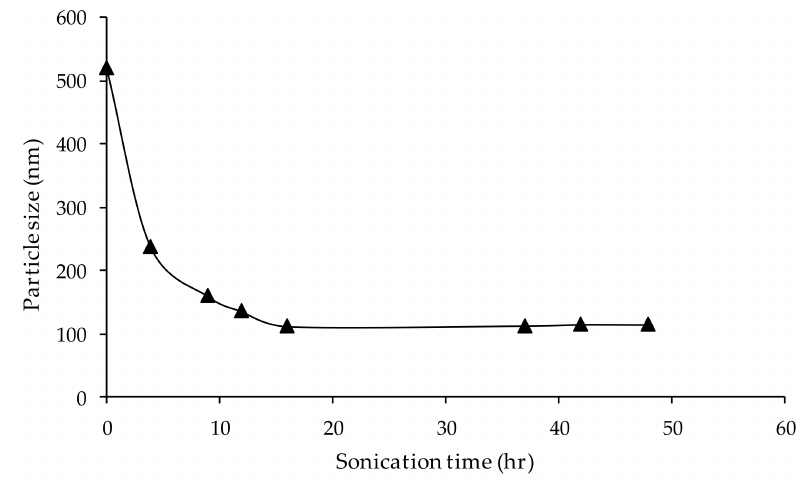
Figure 11. TiO 2 particle size as a function of ultrasonication time